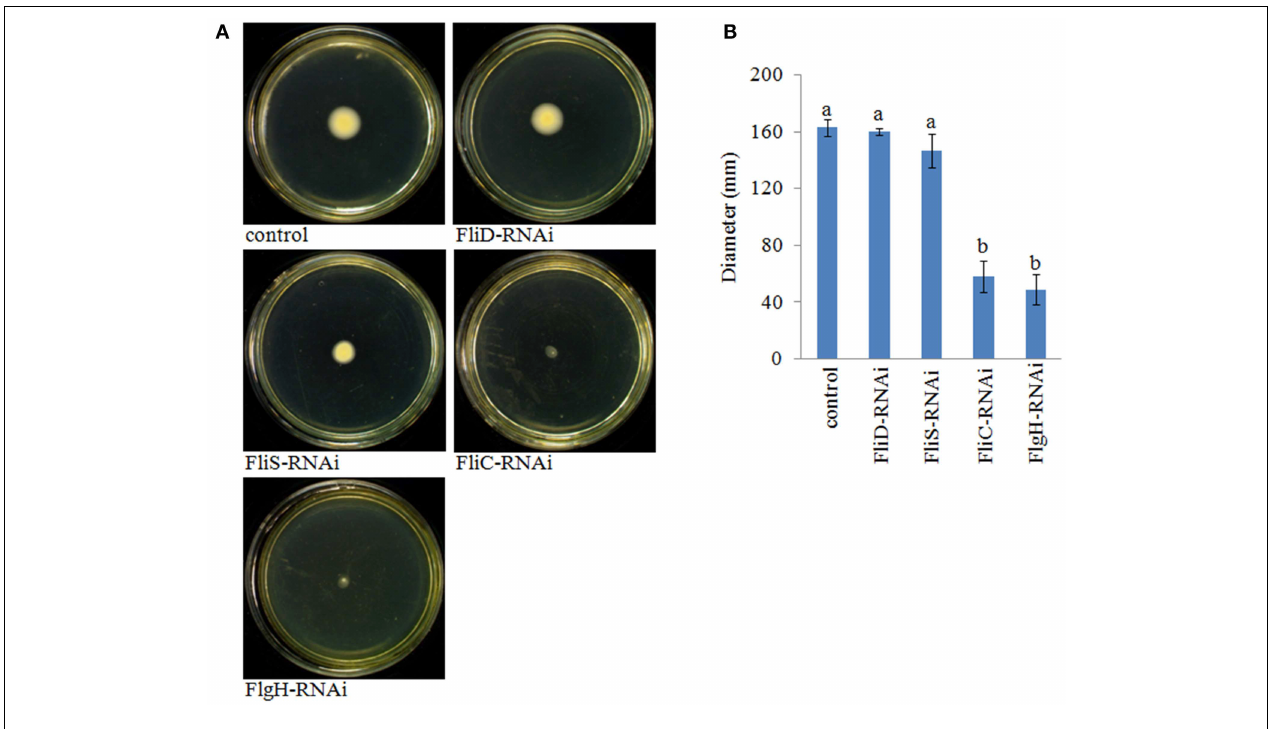
each strain. The data are presented as the means ± S.D. ( n = 3 ). The means of the treatments not sharing a common letter are significantly different at P < 0 . 05 , as assessed using One-Way ANOVA followed by Dunnett’s